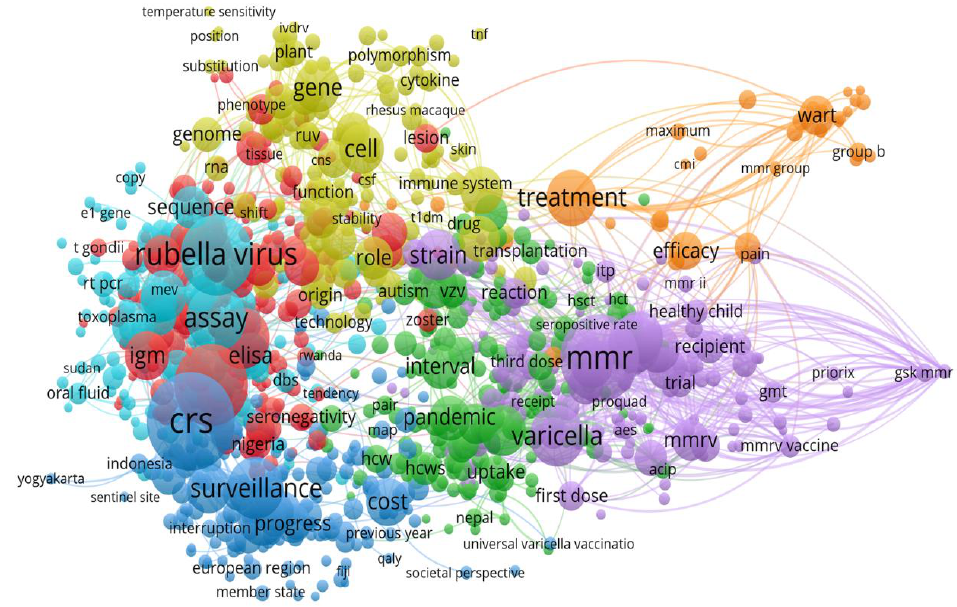
Figure 9. Dominant keywords in publications on rubella virus research.